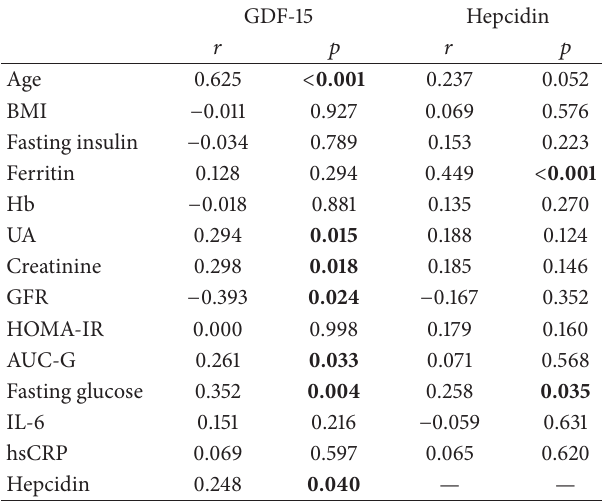
Table 2: Correlations between the demographic and laboratory values and the GDF-15/hepcidin